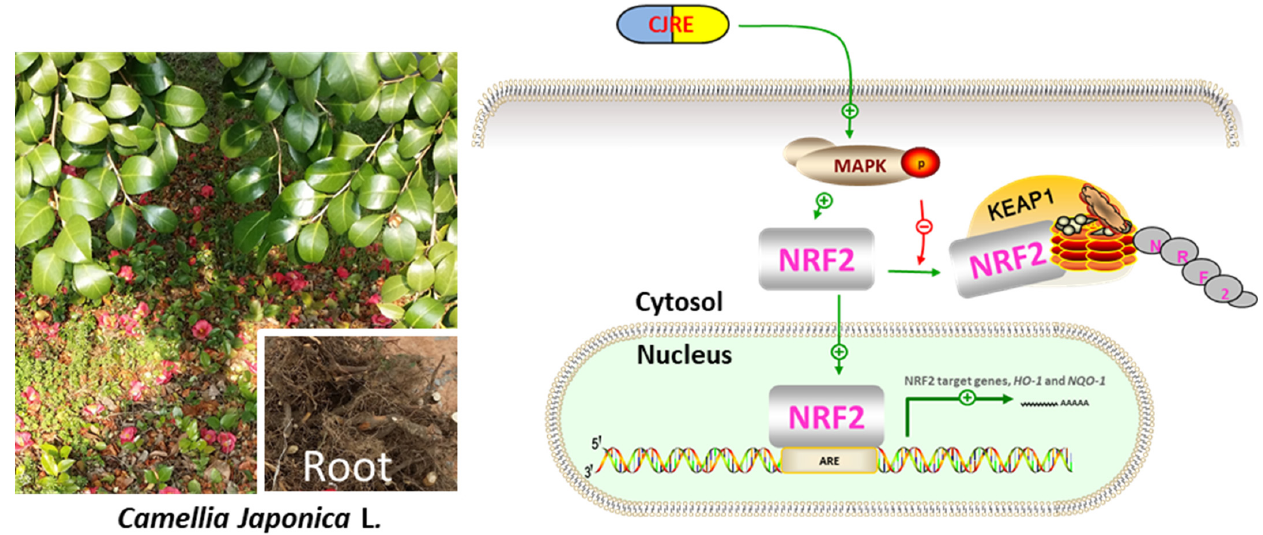
Figure 6. Scheme showing a possible role of CJRE on NRF2 signaling in HeLa cells. CJRE can activate the NRF2 signaling by phosphorylation of MAPK and inhibition of NRF2 degradation, resulting in the induction of NRF2 target genes, such as HO-1 and NQO-1.